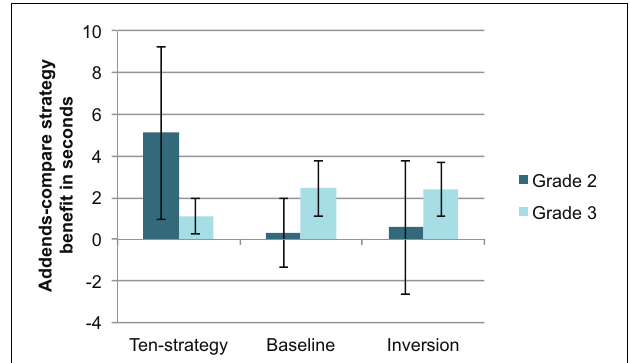
FIGURE 4 | The mean benefit in seconds of booklets allowing for the addends-compare strategy compared to baseline booklets for the three different warm-up conditions (ten-strategy, baseline and inversion) for the second grade (dark gray) and the third grade (light gray) in Experiment 2. The error bar displays the 95% confidence interval of the comparison with zero benefit.